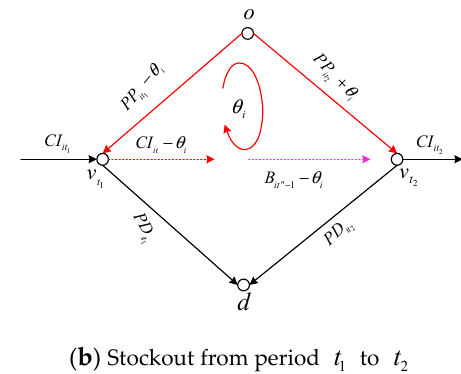
Figure 4. Illustration of augmenting flow in clockwise cycle.